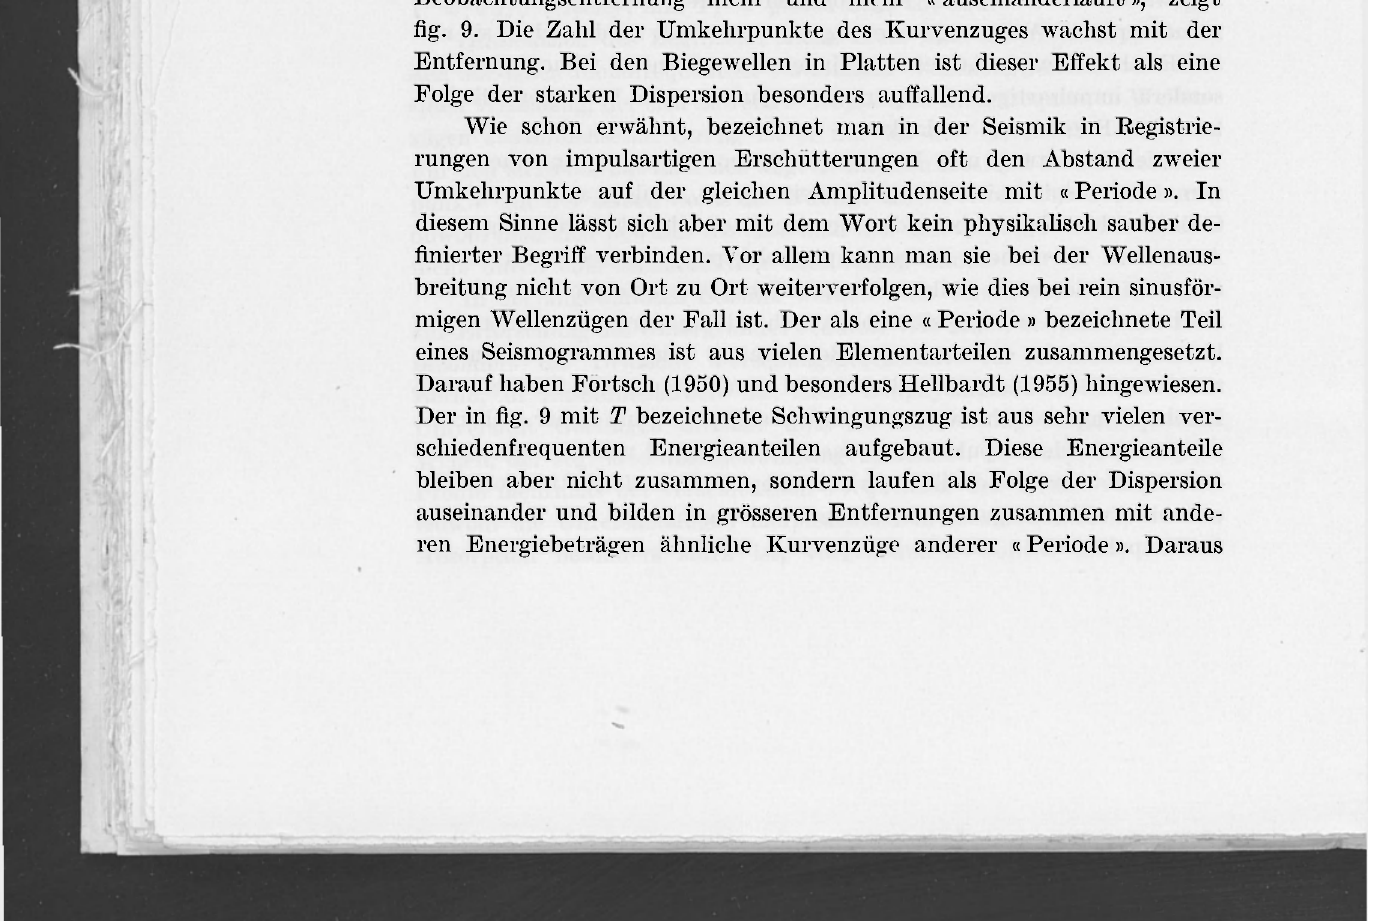
fig. 9. Die Zahl der Umkehrpunkte des Kurvenzuges wachst mit